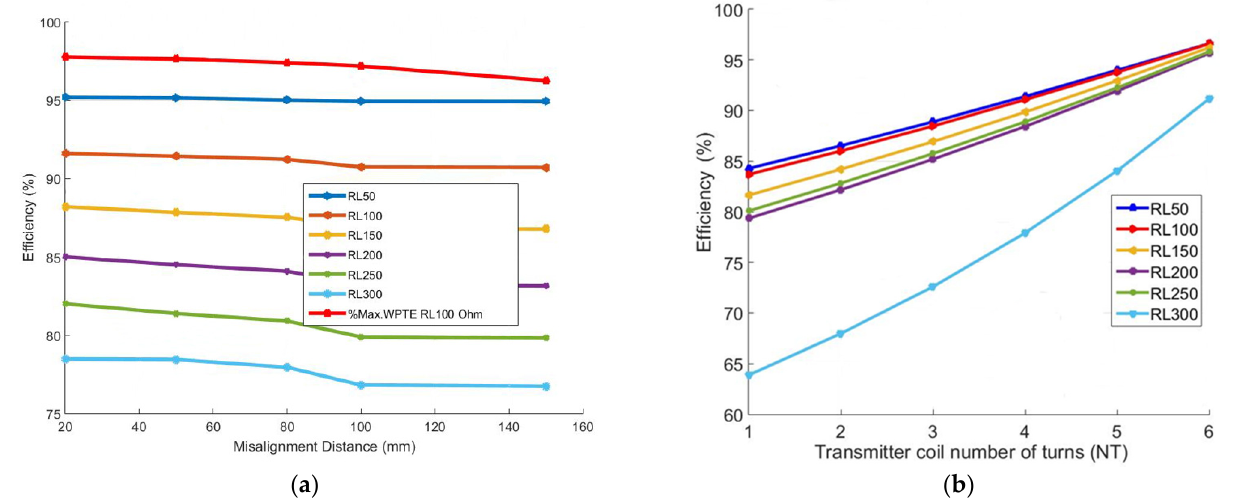
Figure 16. Comparison of different R L values in simulation between STLAC. ( a ) The drone’s available distance range was between 2 to 15 cm and MTSCC (fixed) in lateral misalignment for improving transfer efficiency at 20 mm distance; and ( b ) the best selection results of the transmitter of design coil in simulation.